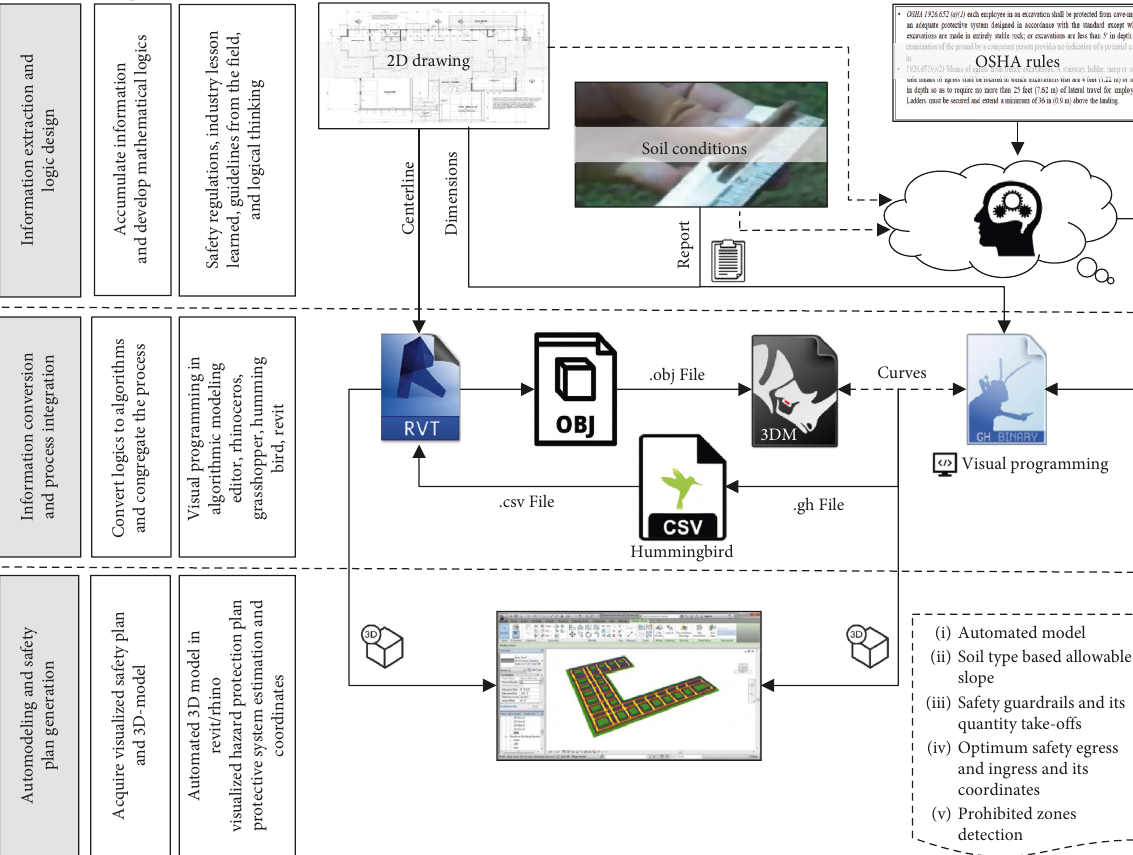
Figure 2: System architecture for auto-exca safety planning model approach.